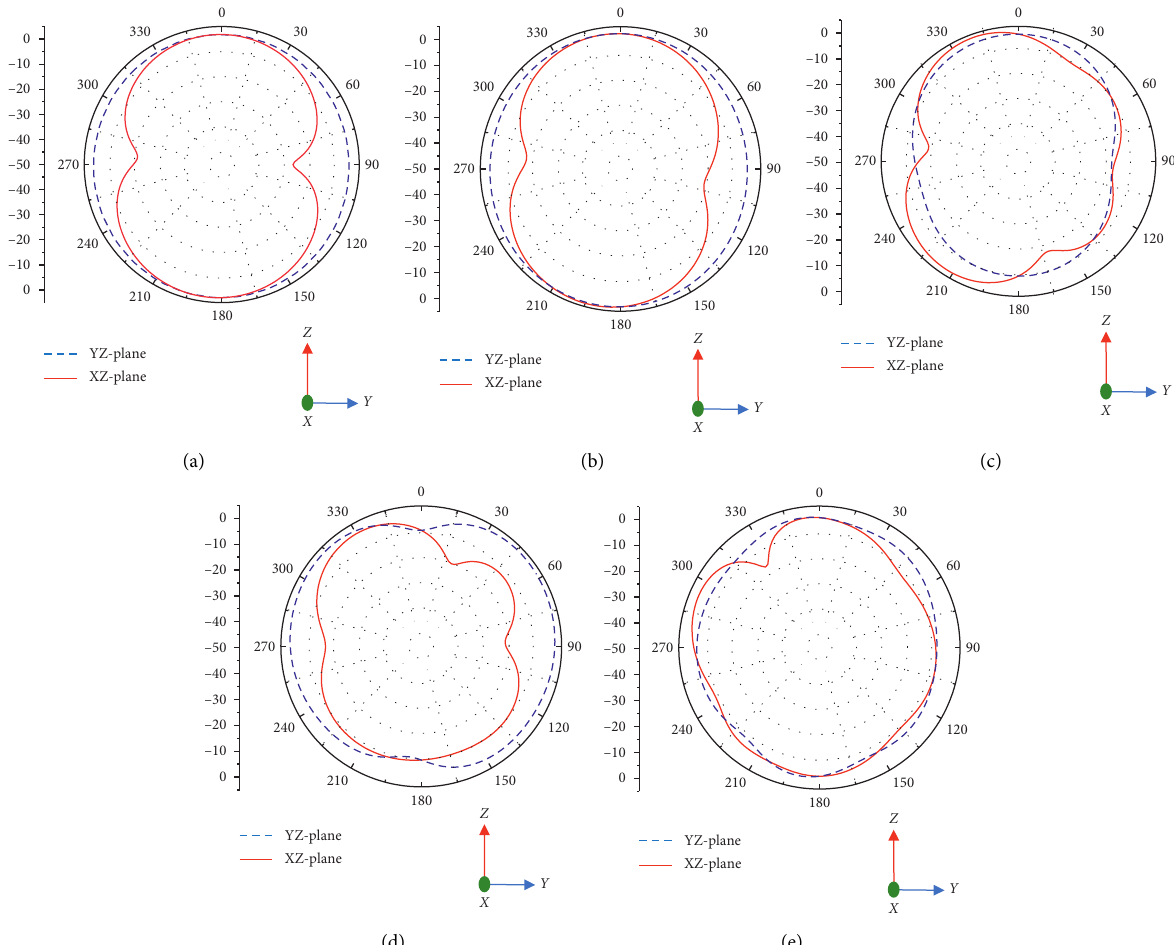
Figure 11: Simulated radiation pattern of proposed